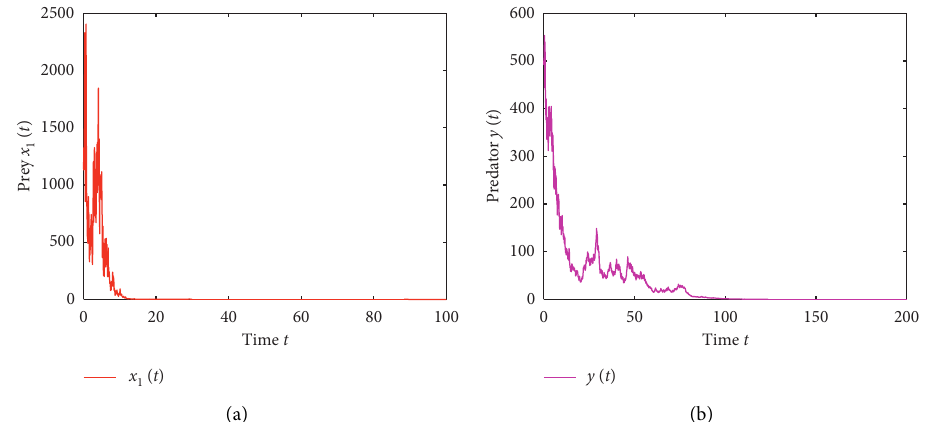
Figure 13: The trajectories of (5) with σ 2 ( t ) prey x 2